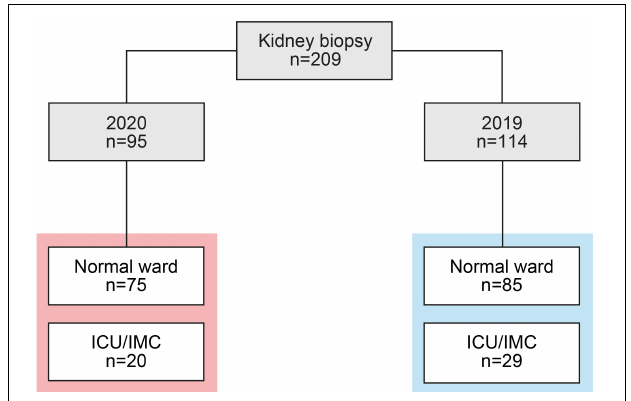
FIGURE 1 | Total cohort of renal biopsies. STROBE flow chart of patient disposition, RRT was performed intermittently in all cases. STROBE, Strengthening the Reporting of Observational Studies in Epidemiology.